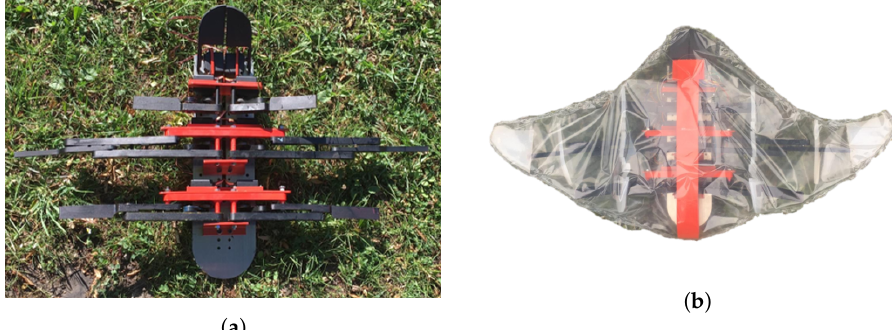
Figure 20. Bioinspired robot without ( a ) and with ( b ) the external